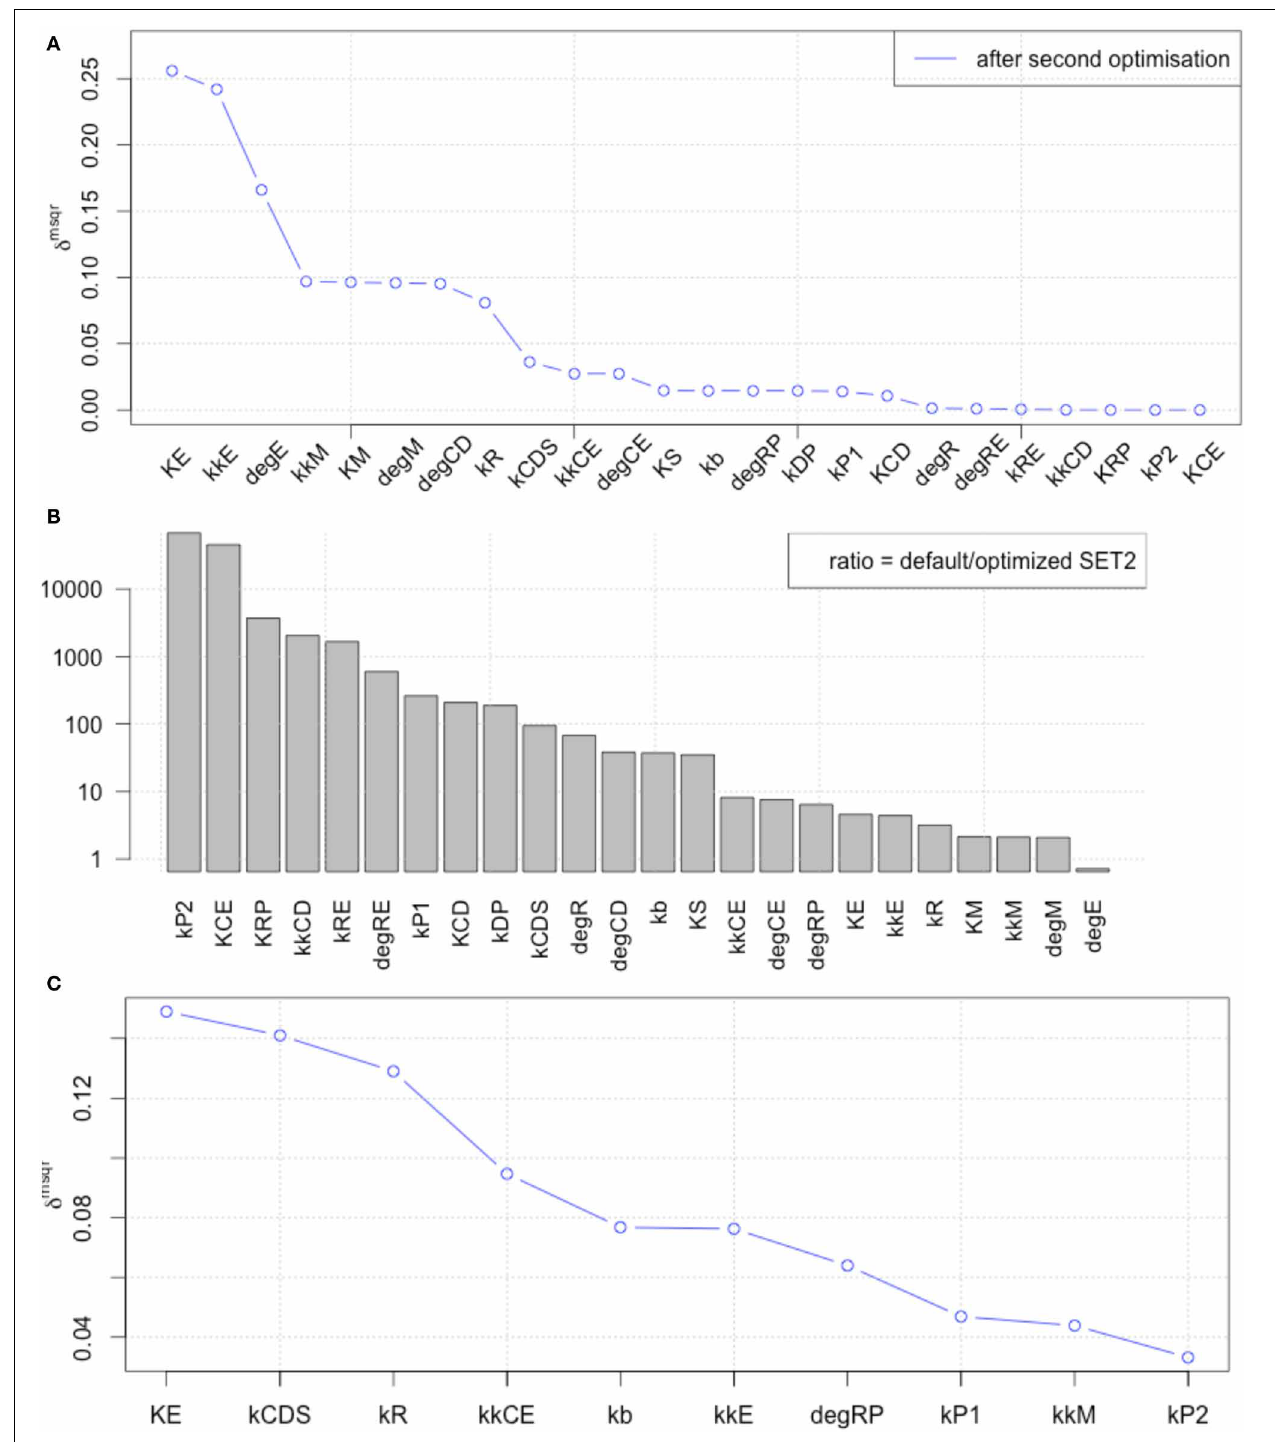
FIGURE 7 | The results of LSA (A,B), and GSA (C) with the 2nd set of optimized parameters. All the parameters show less sensitivity than the original or the 1st set of optimized parameters.